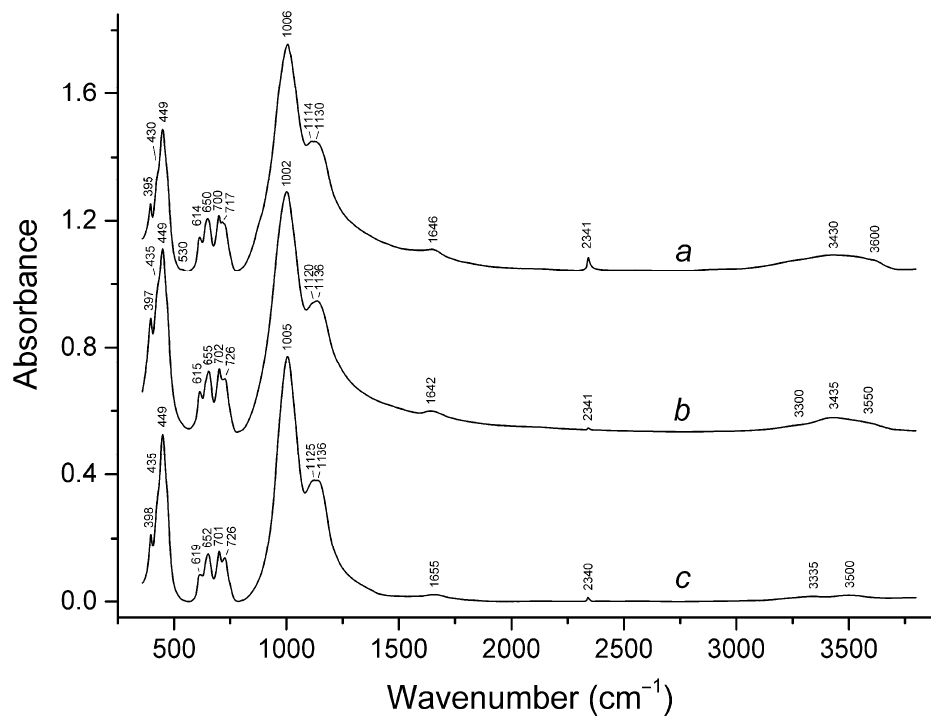
Figure 6. Infrared absorption spectra of the haüyne samples ( a ) LSh, ( b ) MD, and ( c ) Hn7981.